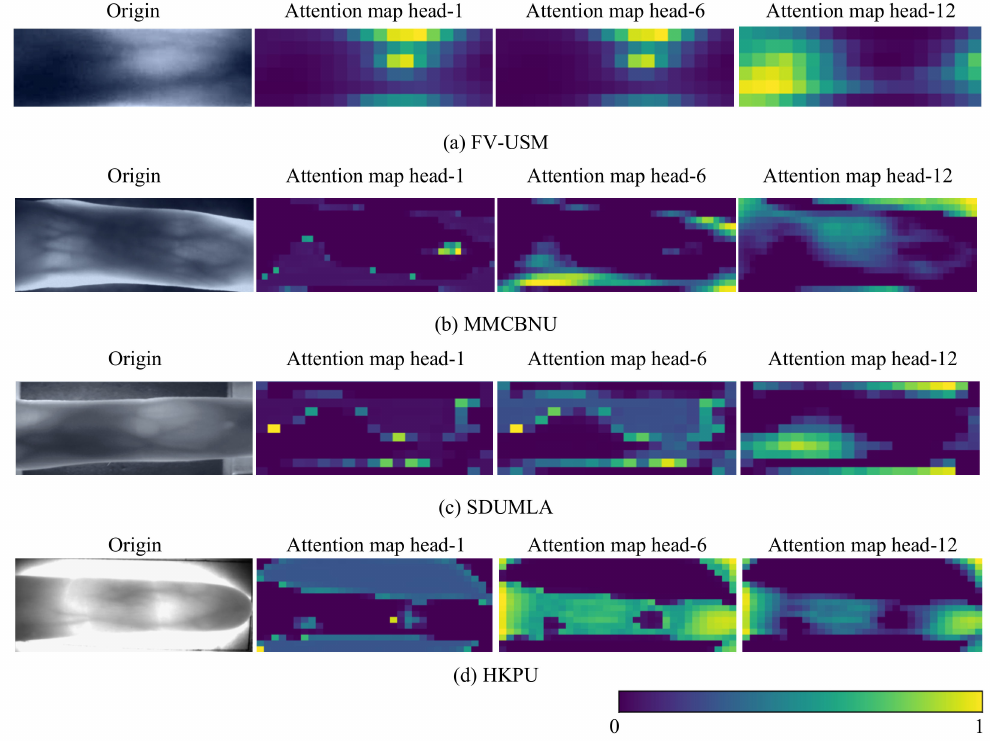
Figure 4. Attention maps obtained on four public finger vein